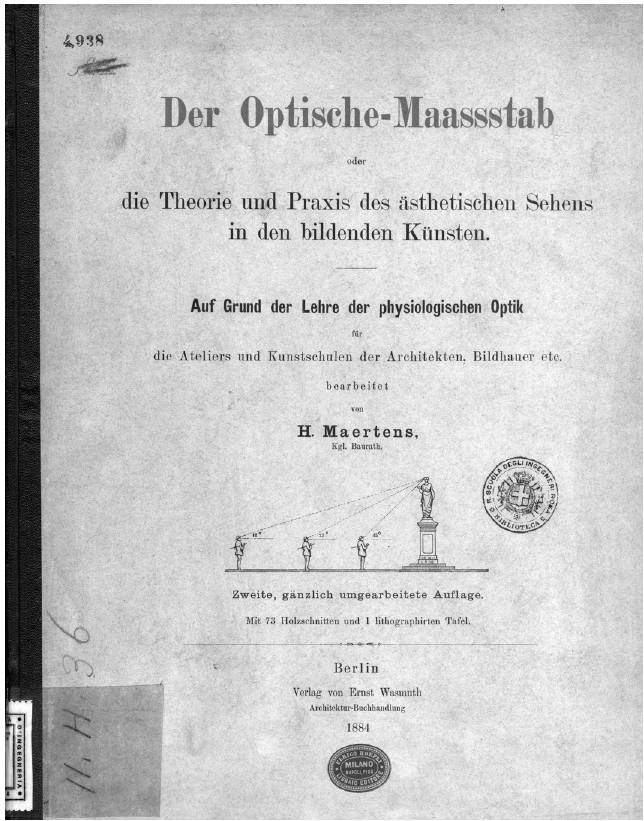
Fig. 1 Hermann Maertens, Der Optische-Maassstab , Cover of the second edition (Maertens,